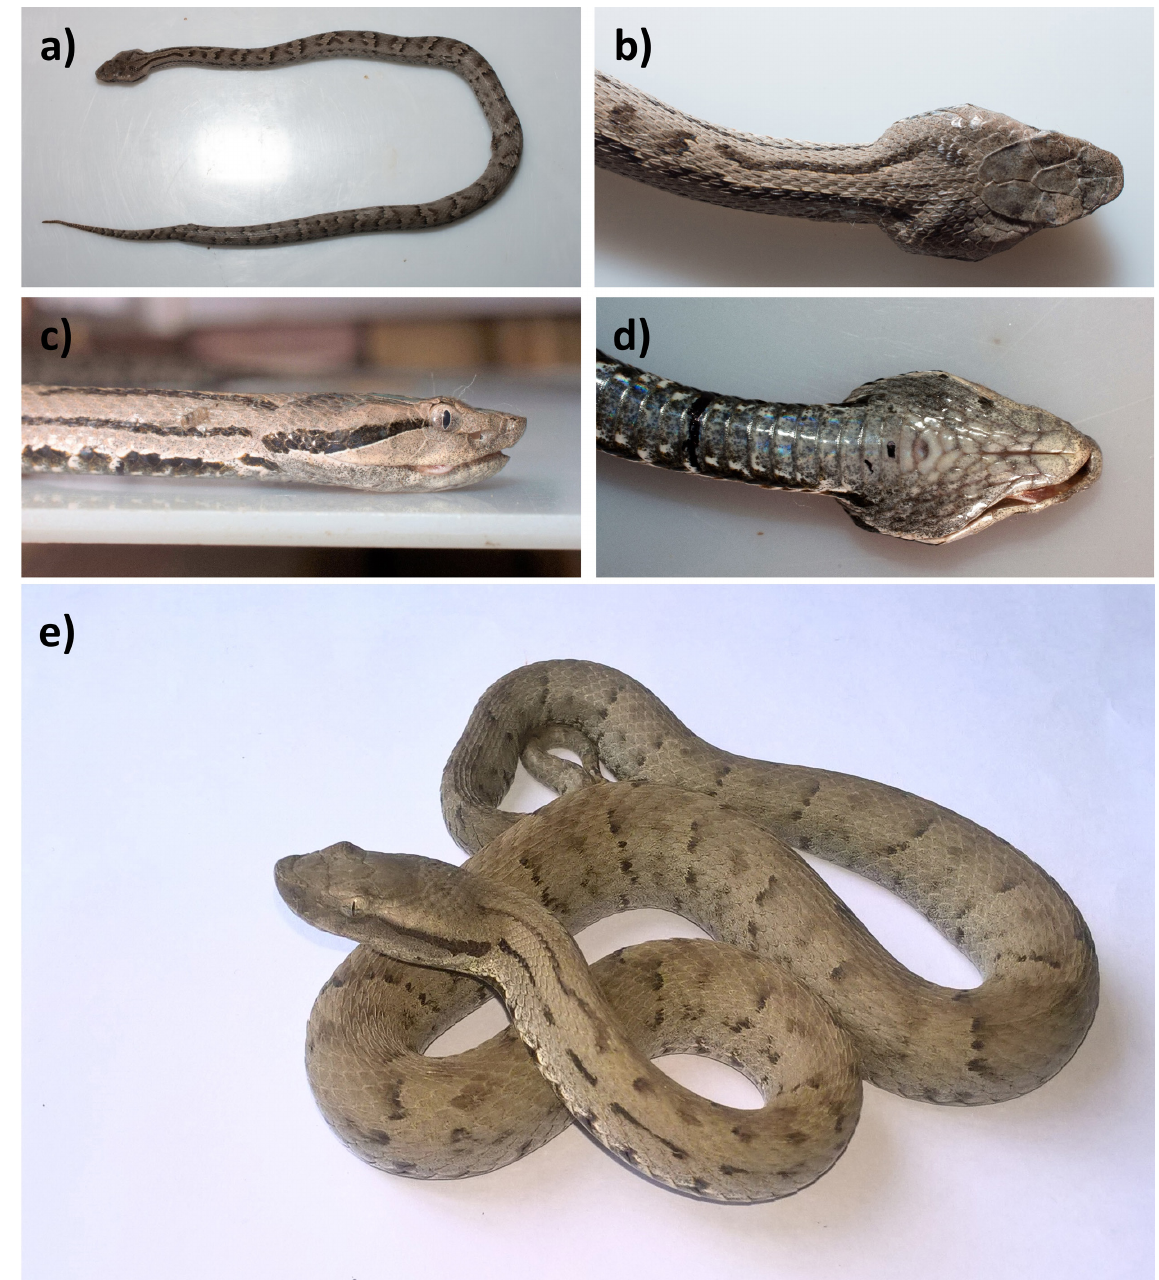
Fig. 7. a–d . Gloydius chambensis sp. nov., holotype, ♂ (Specimen Number 18.13; Churah Valley, HARC R359). a . Whole body b–d . Close-up of the head in dorsal (b), lateral (c) and ventral (d) views. d . The first and 10 th ventrals have been marked with black marker to assist with counting scales. e . A whole body view of specimen 17.v20 from Bhanjraru, Chamba. Photos provided by J.B. Owens and V.